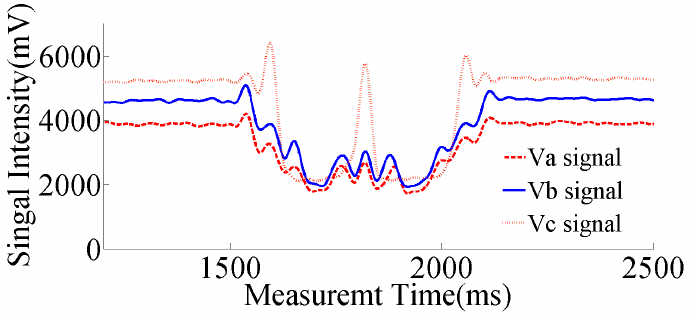
Figure 6. Example of the measured temporal signals of V a , V b and V c . Table 1. Direction angle α and velocity data of V a , V b and V .